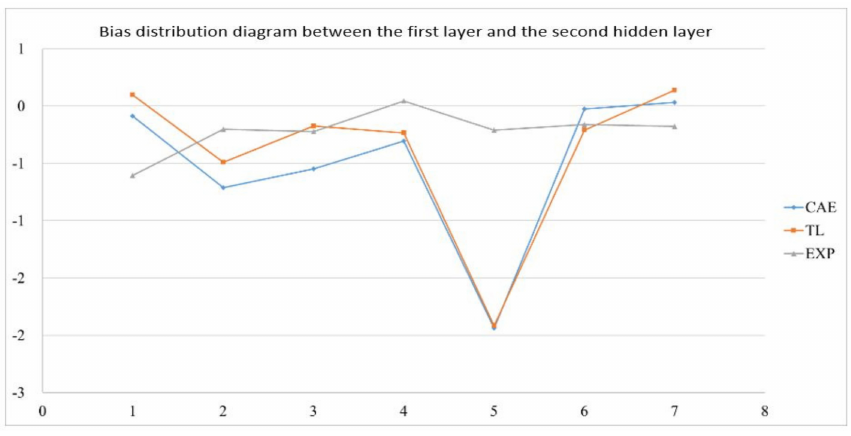
Figure 23. Bias distribution diagram between the first layer and the second hidden